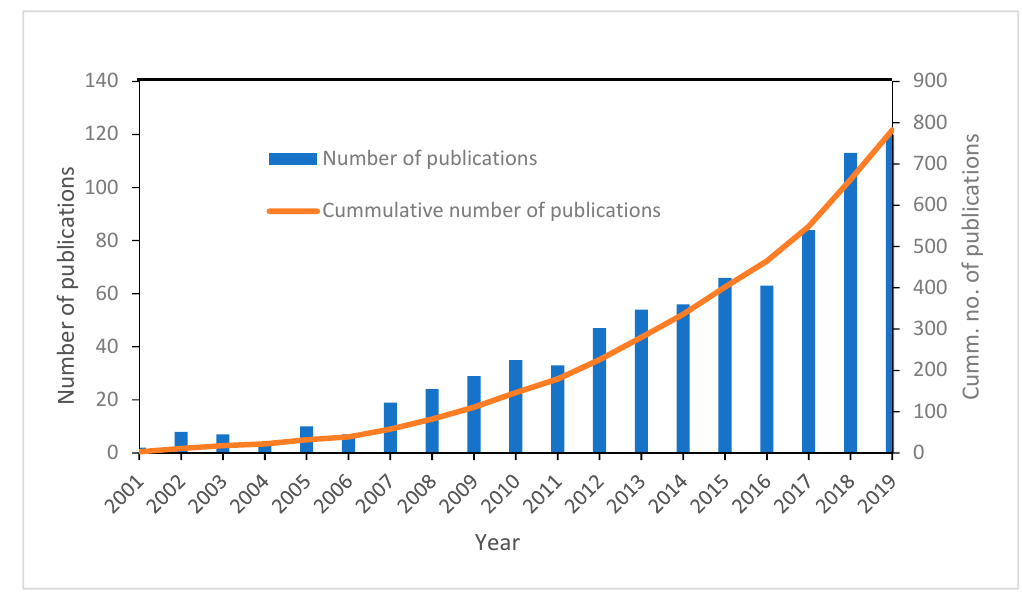
Figure 2. Timeline distribution of the annual and cumulative number of publications on the use of advanced oxidation processes for the degradation of pharmaceuticals.